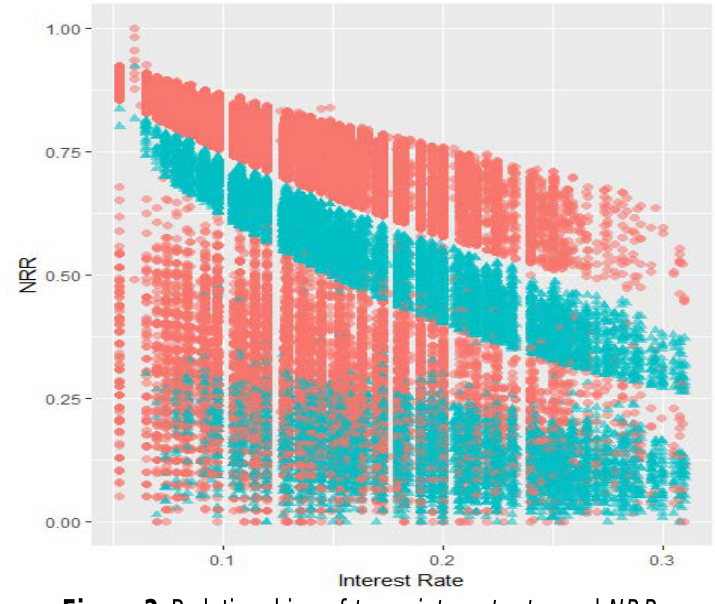
Figure 2. Relationships of term , interest rate , and NRR